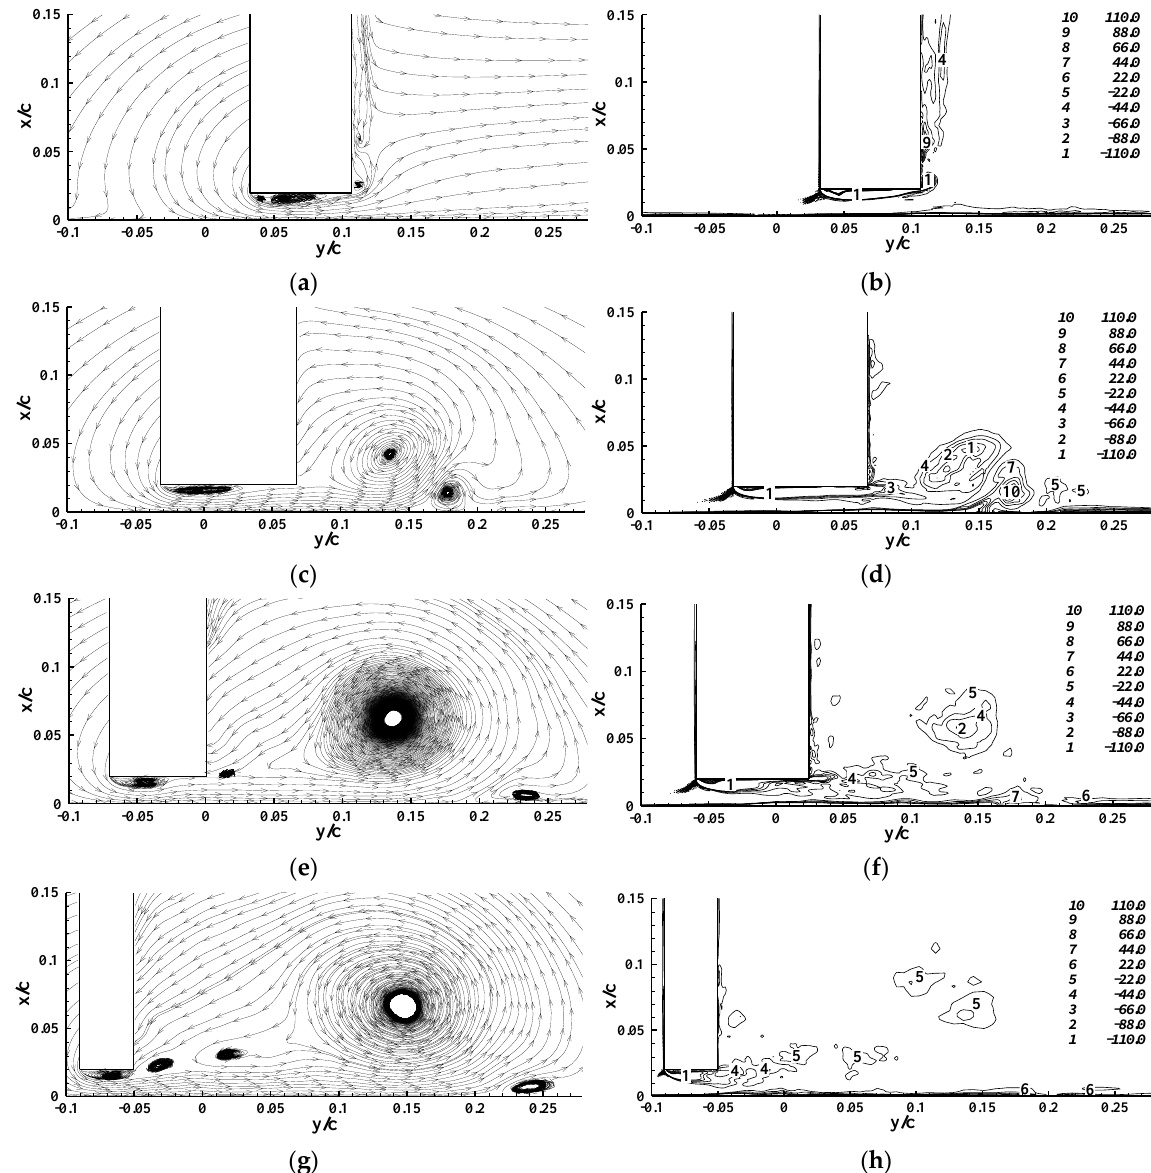
Figure 10. Mean streamlines and the corresponding contours of non-dimensional mean streamwise vorticity in x-y planes: ( a , b ) for z / c = − 0.4, ( c , d ) for z / c = − 0.1, ( e , f ) for z / c = 0.2, and ( g , h ) for z / c = 0.4.